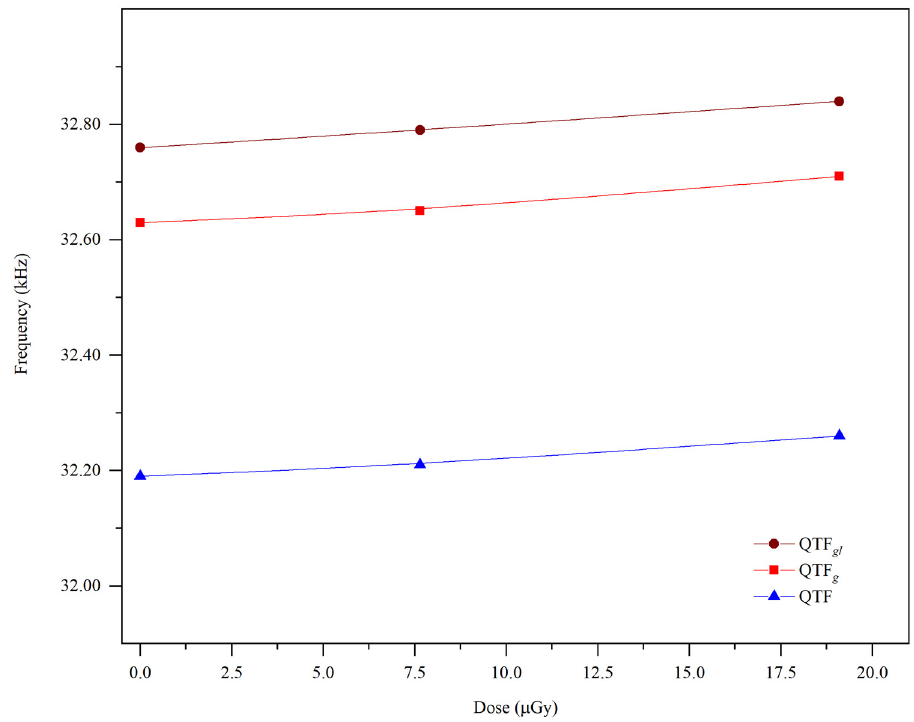
Figure 4. Comparison of resonance frequency shift of QTF g , QTF gl , and QTF as a function of different dose levels.